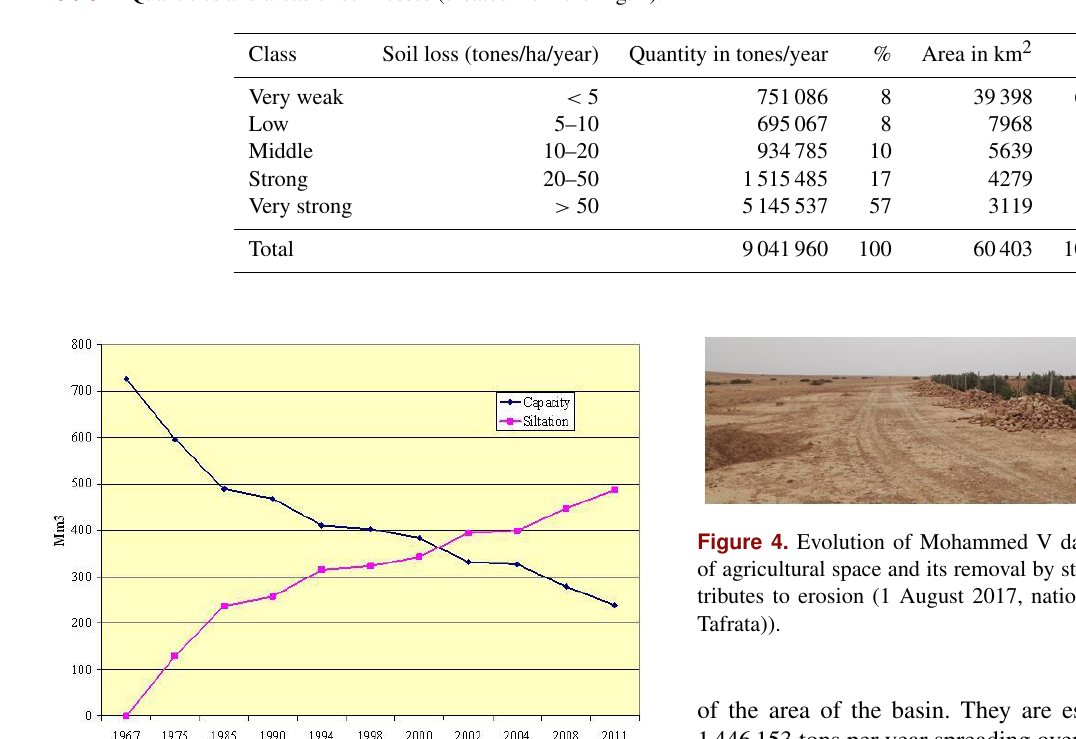
Table 2. Quantities and areas of soil losses (created from the Fig. 2).